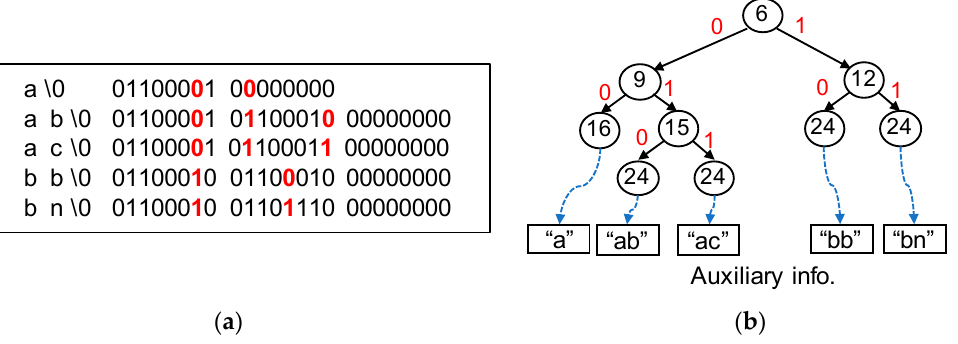
Figure 6. An example of key strings and its Patricia trie: ( a ) five key strings and their bit representations and ( b ) the corresponding Patricia trie to ( a ).